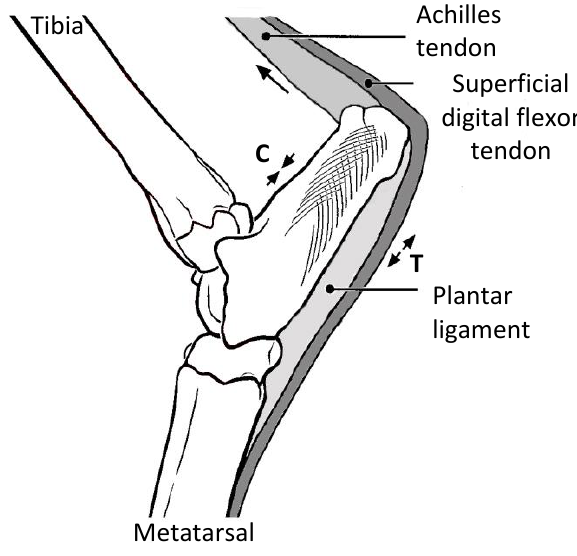
Figure 1: Lateral view of the tarsal region of a skeletally mature artiodactyl, showing the calcaneus with other associated bones, ligaments and tendons. The large arrow in the dorsal direction indicates the orientation of the force exerted by the Achilles tendon during paw extension, loading the dorsal cortex in compression ("C") and the plantar cortex in tension ("T"). Modified from Su et al.